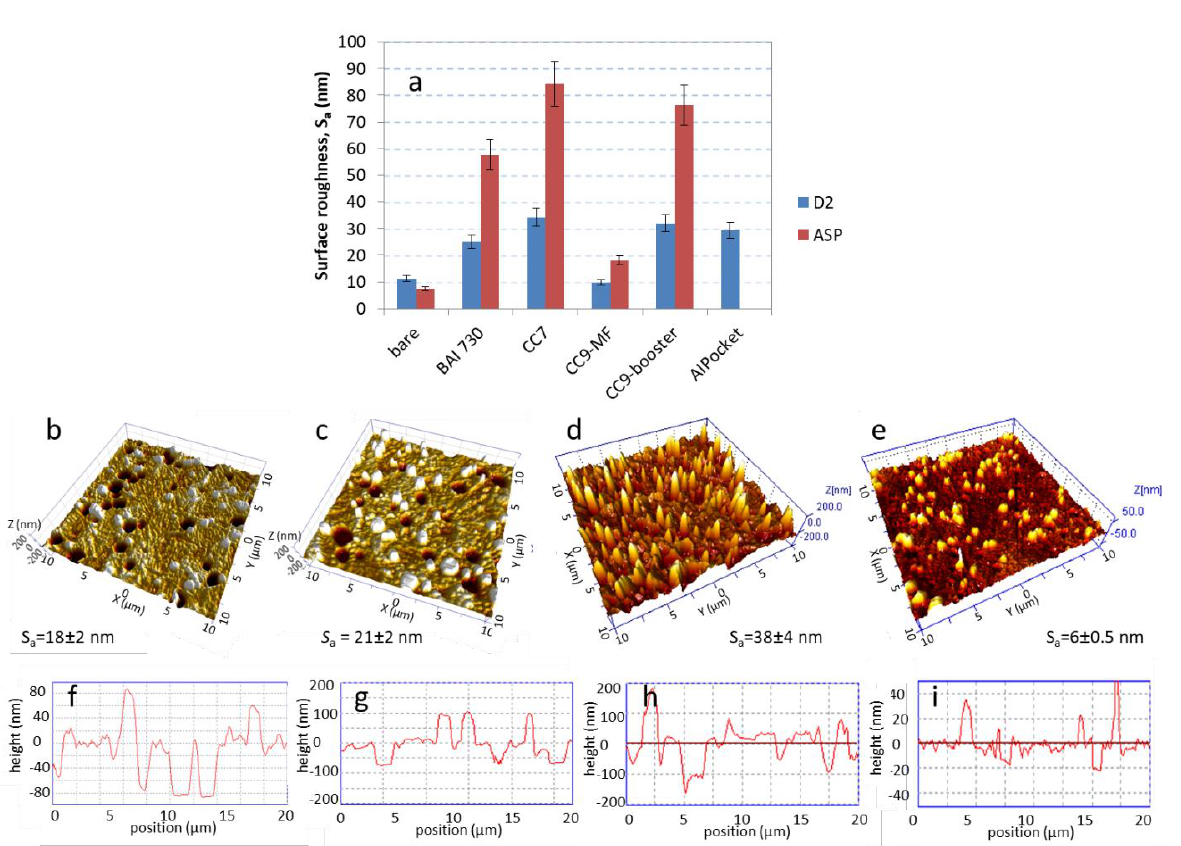
Figure 4. AFM surface roughness of different substrates (M2, ASP, D2, SS 316L) before and after MF and MF + booster ion etching. The scan area was 20 µm × 20